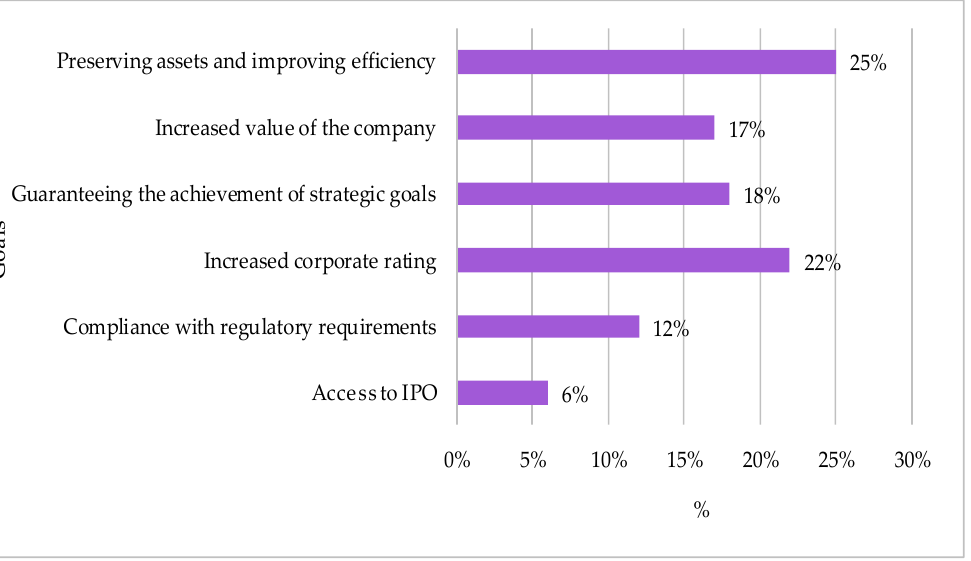
Figure 1. Objectives of introducing risk-based management in 50 Polish companies. Source: authors’ study.